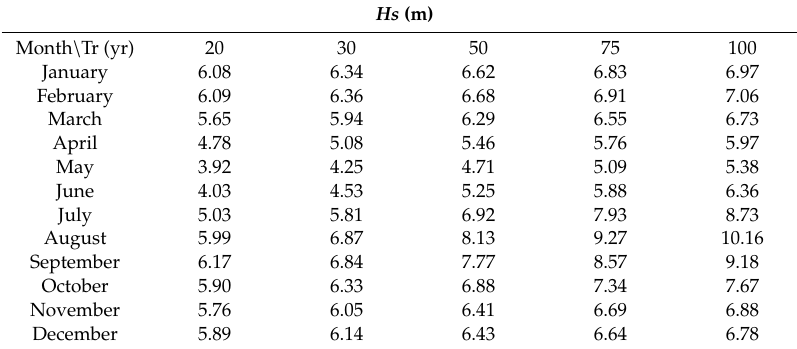
Table A1. Selected return period values for Hs in each month.